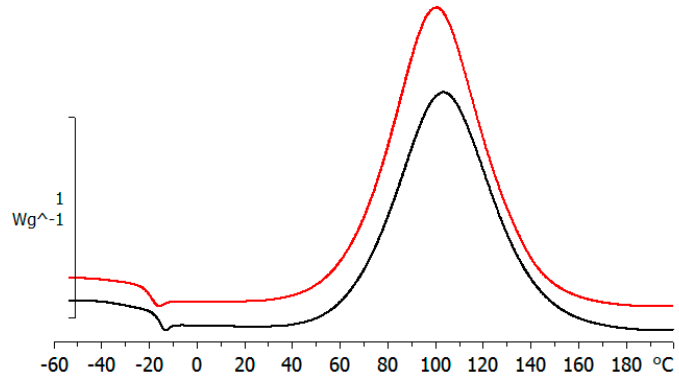
Figure 4. DSC scan for ELP800 (red line, upper curve) and ELP25000 (black line, lower curve) at 10 °C/min.